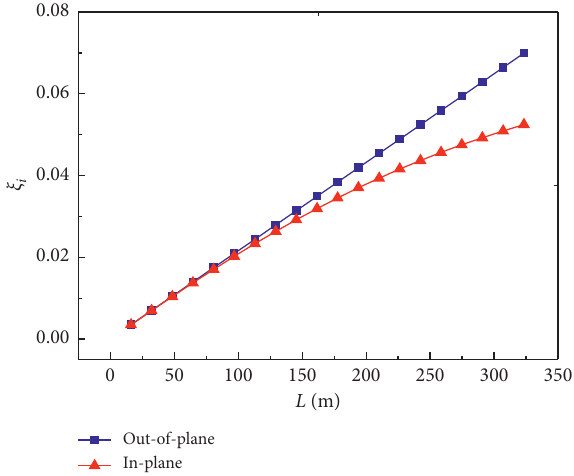
Figure 12: Relationship between first order modal damping ratios and length of tether.